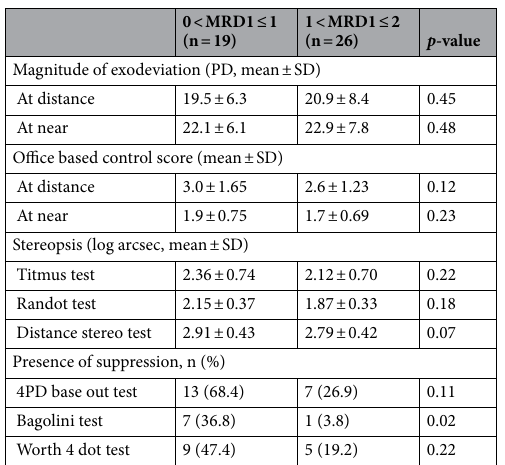
Table 2. Comparison of characteristics according to margin reflex distance 1. MRD1 margin reflex distance 1, PD prism dioptres, SD standard